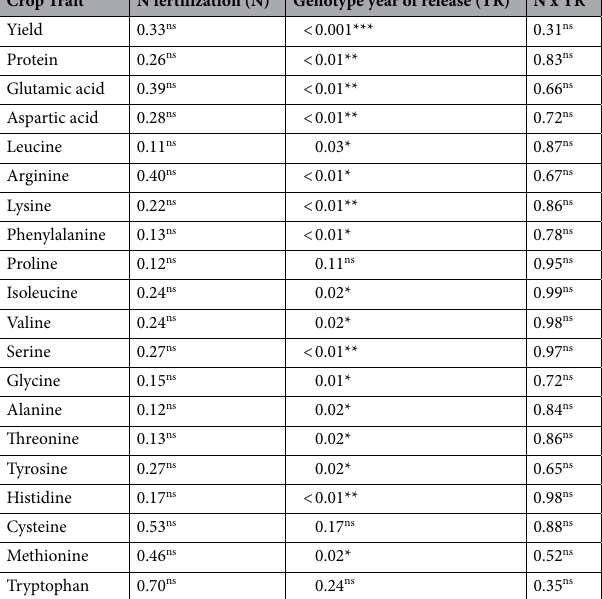
Table 1. Analysis of variance F -test probabilities for nitrogen fertilization and genotype year of release affecting soybean